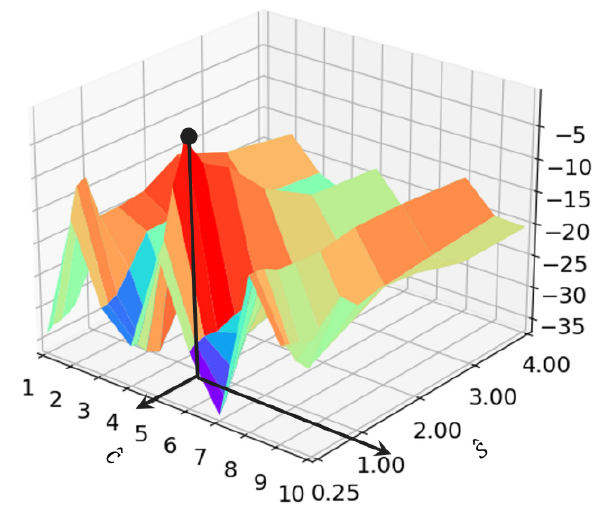
Figure 8. Visualization of output response.